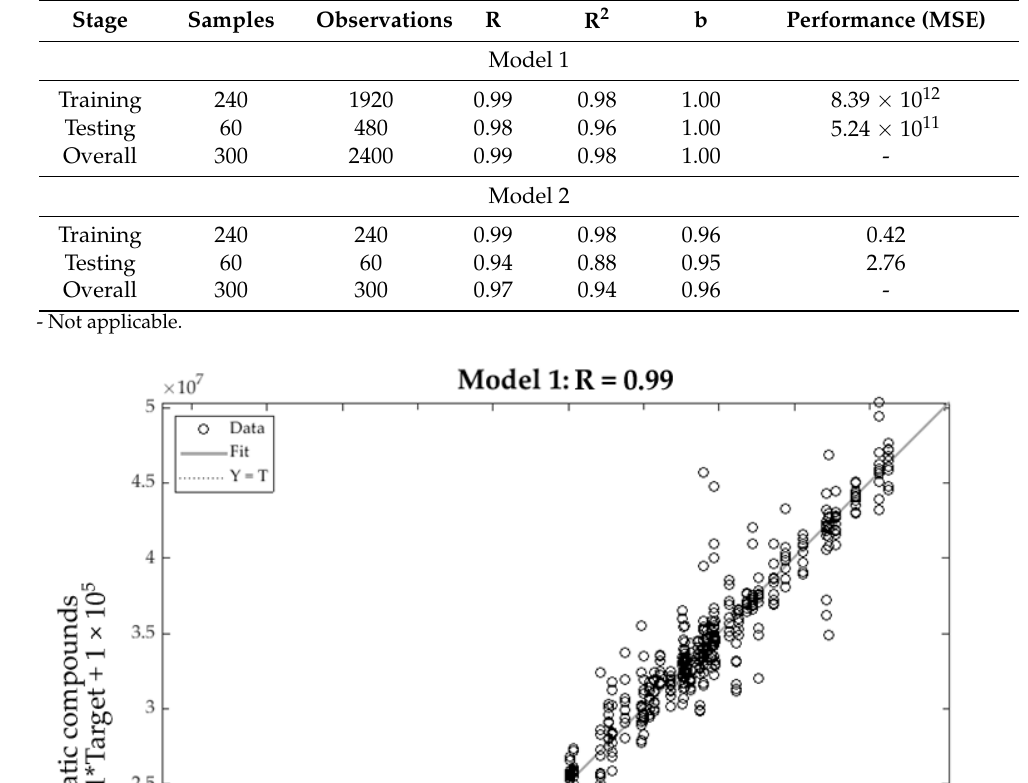
Table 2. Statistical results for the artificial neural network models developed to estimate the levels of volatile aroma compounds (Model 1) and smoke aroma intensity (Model 2) in wine, showing the correlation coefficient (R), determination coefficient (R 2 ), slope (b), and performance based on mean squared error (MSE) for each stage.